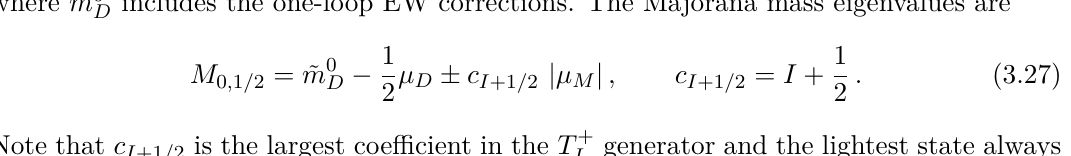
Figure 3. Feasible range for Y = 1 / 2 , I = 3 / 2 (Left) and I = 5 / 2 (Right) in the presence of a Majorana dim-5 coupling. The lines from solid to dotted correspond to µ The region with a lightest neutral component lies between the two lines. The yellow shaded region is excluded by the Z decays into the multiplet